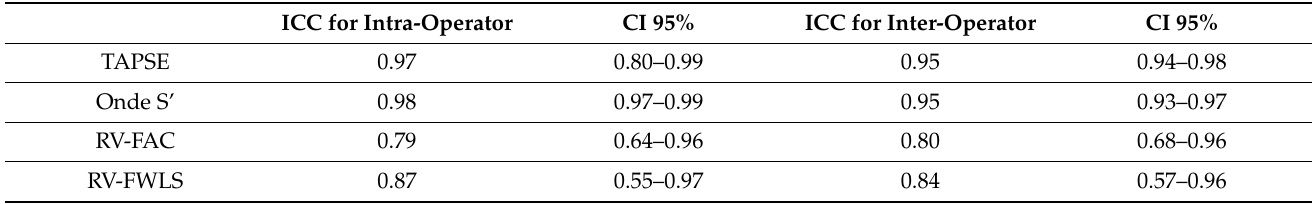
Table A1. Reproducibility of RV conventional and strain